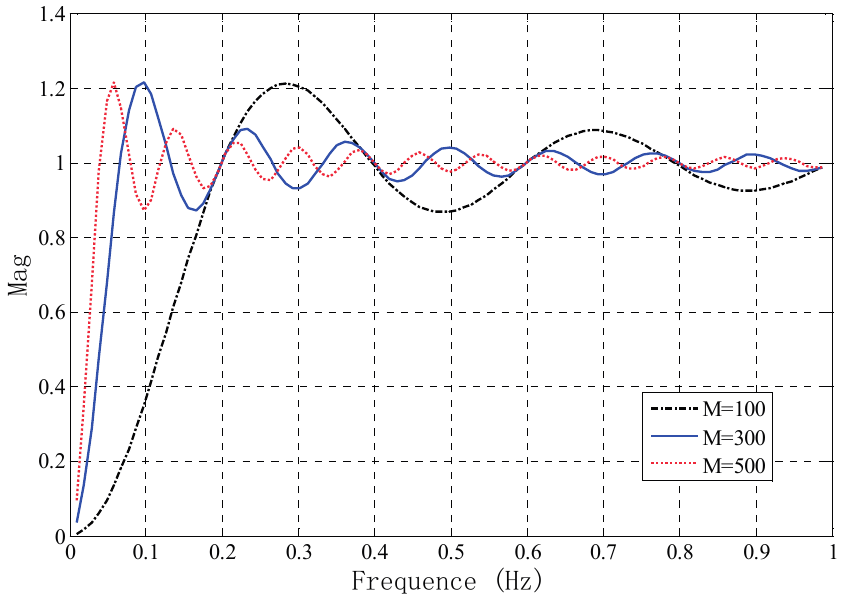
Figure 3. The frequency response of the system for different filter orders.